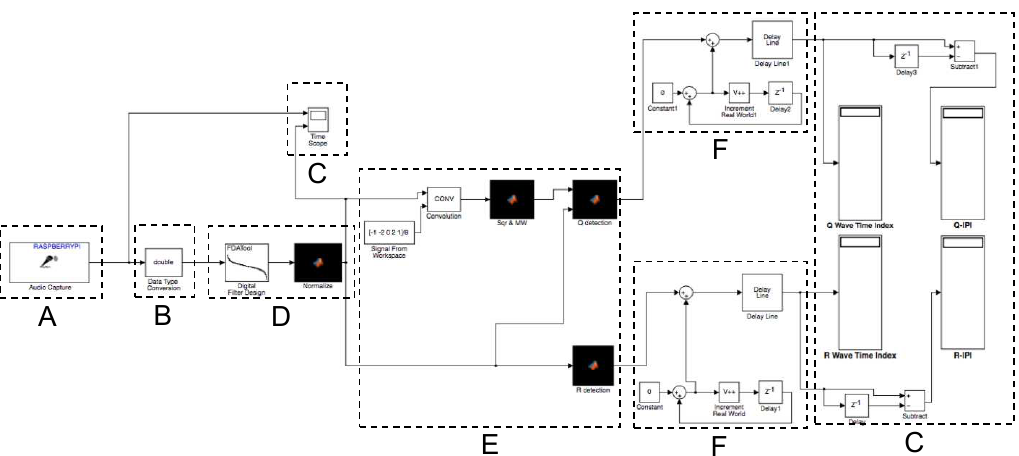
Figure 9. Block diagram of the Simulink Model. ( A ) data acquisition; ( B ) data conversion; ( C ) output; ( D ) lowpass filter; ( E ) Pan–Tompkins QRS detection; and ( F ) time